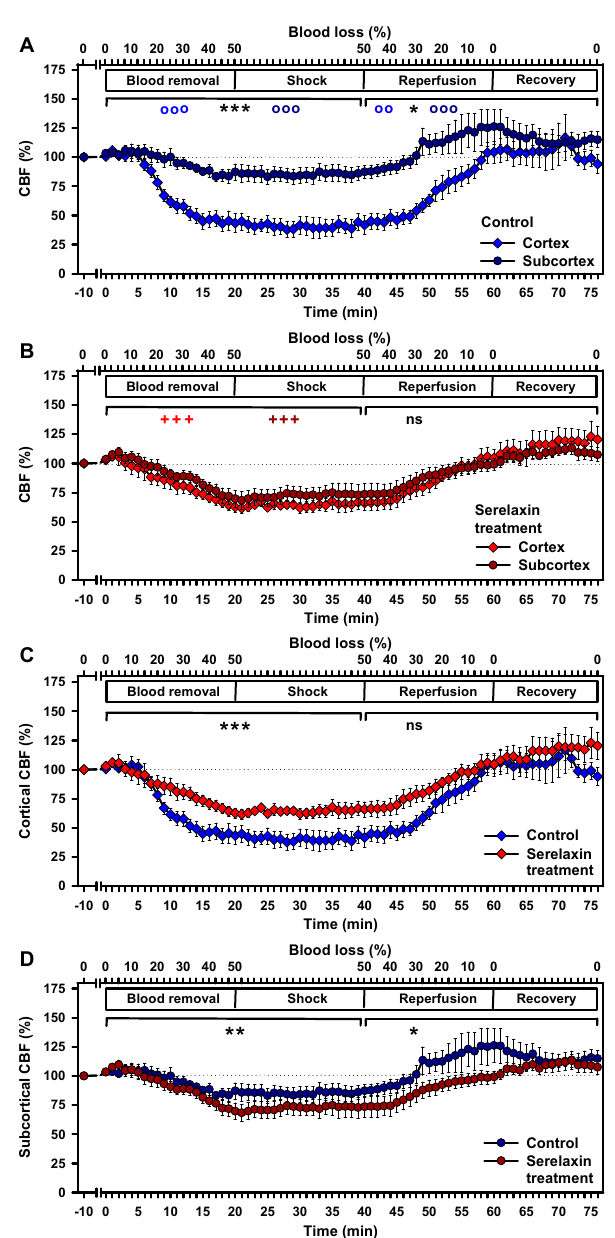
Figure 6. Effects of controlled hemorrhage with a resulting shock period and reperfusion on cortical and subcortical CBF. Comparison of cortical and subcortical CBF in the control group ( A ) and under serelaxin treatment ( B ). Comparison of controls and serelaxin treatment for the cortex ( C ) and subcortex ( D ). Linear mixed models were separately calculated for hypoxia and reoxygenation versus baseline values. oo, p < 0.01; ooo, p < 0.001 for the comparison of the control group with baseline values. +++ p < 0.001 for the comparison of the serelaxin-treated group with baseline values. * p < 0.05; ** p = 0.002; *** p < 0.001 for the comparison between the two experimental groups. Dotted lines indicate baseline